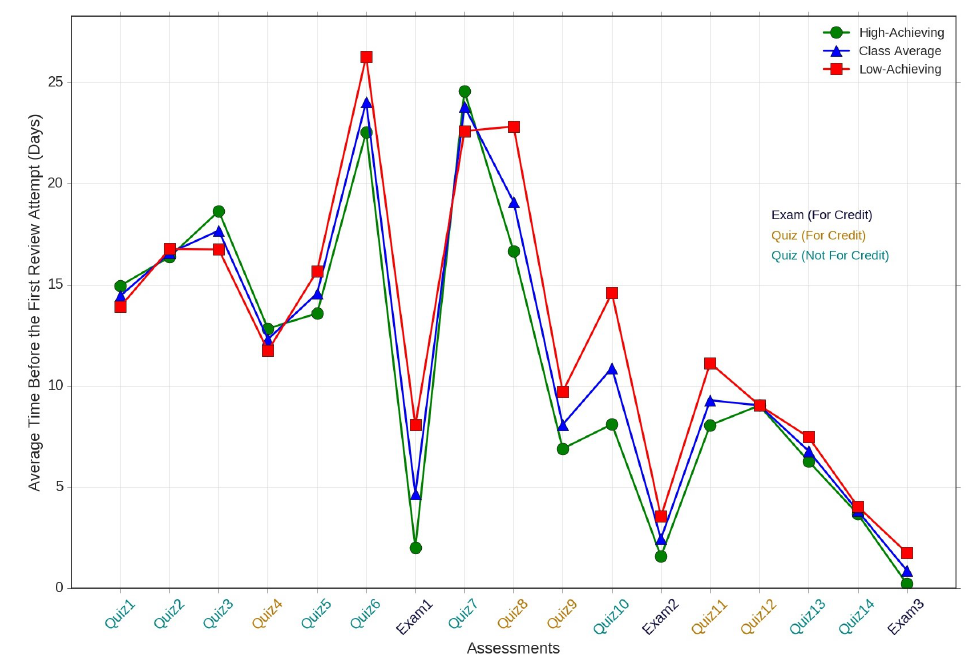
Figure 3. Comparison of how soon students review their graded assessments (reviewing delay) between the high-achieving and low-achieving